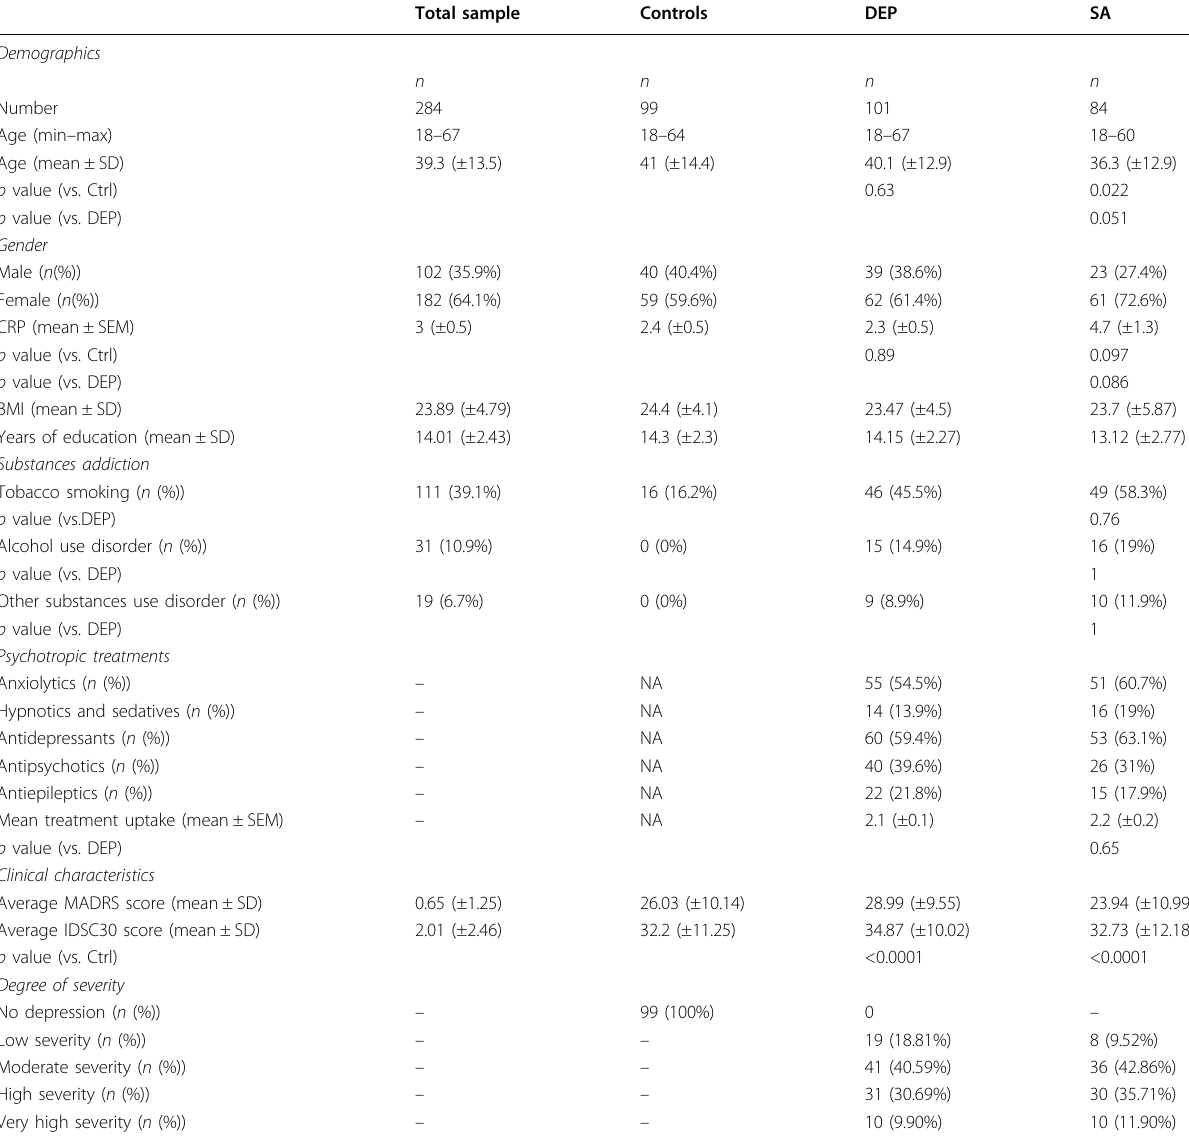
Table 1 Demographic characteristics of participants and psychiatric diagnosis of patients. Total sample